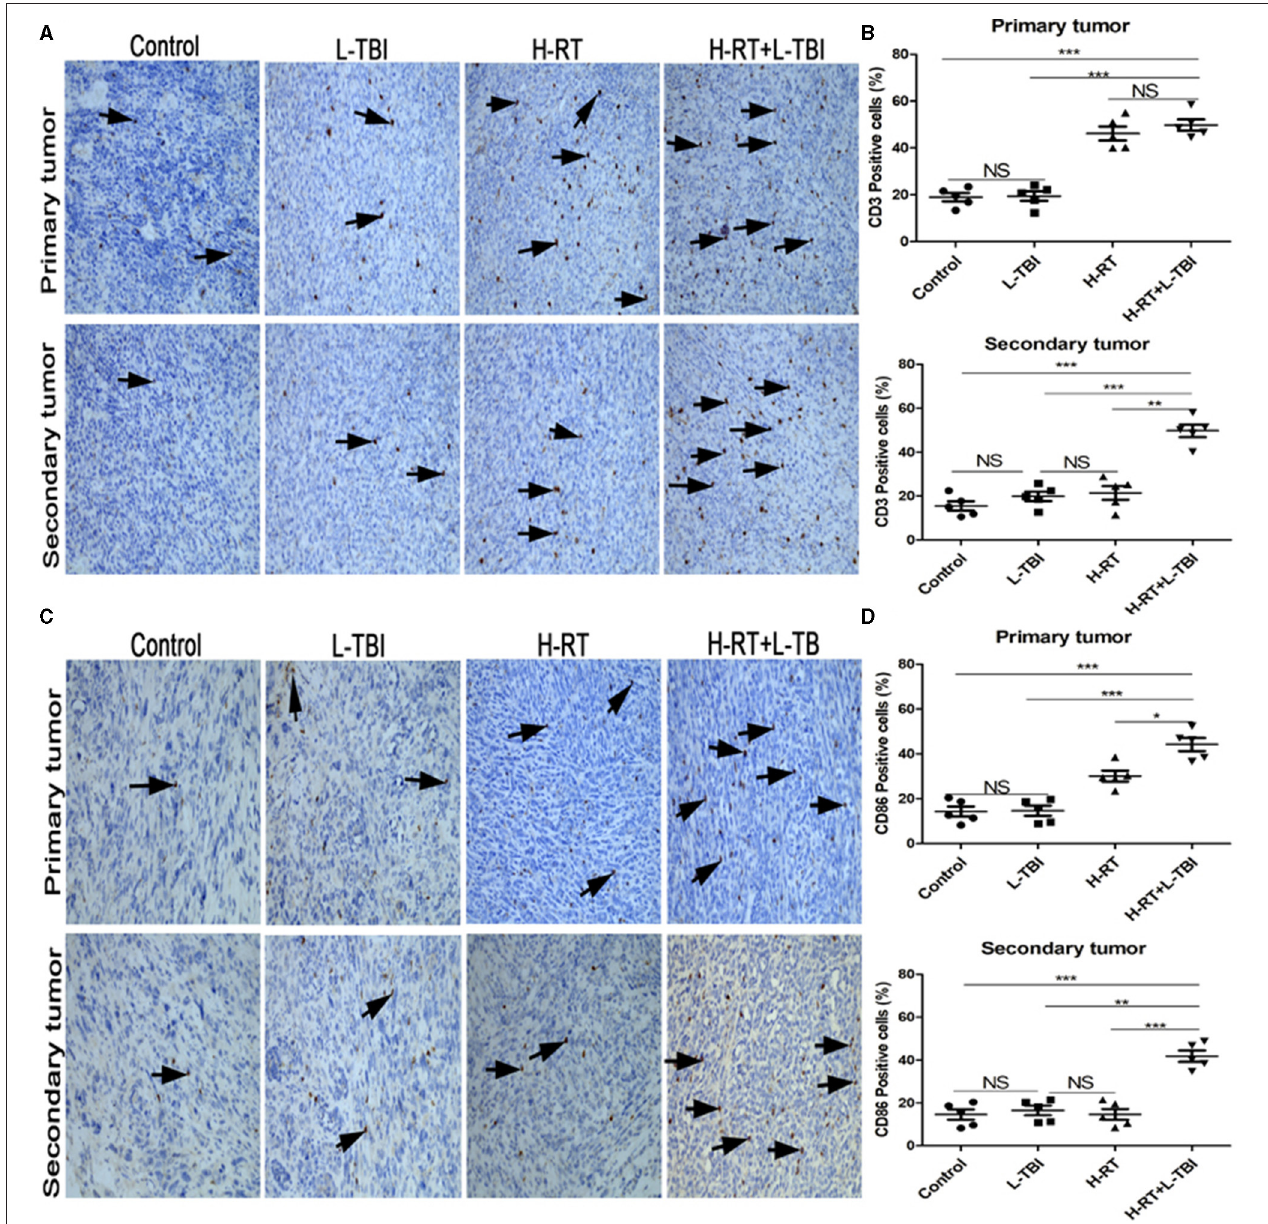
FIGURE 4 | Comparison of CD3 + and CD86 + lymphocytes in different treatment groups. (A) Representative images of CD3 IHC in tumor tissues of different treatment groups. (B) Percentage of CD3 positive cells in the primary and secondary tumor. (C) Representative IHC images of CD86 infiltration in the tumor tissue of different treatment groups. (D) Percentage of CD86 positive cells in the primary and secondary tumor. The arrows point the CD3 and Cd86 positive cells in tumor tissues from mice that received different treatments (original magnification × 200). Data are expressed as mean ± SE of 5 mice/group. (* P < 0.05, ** P < 0.01, *** P < 0.001, and NS = not